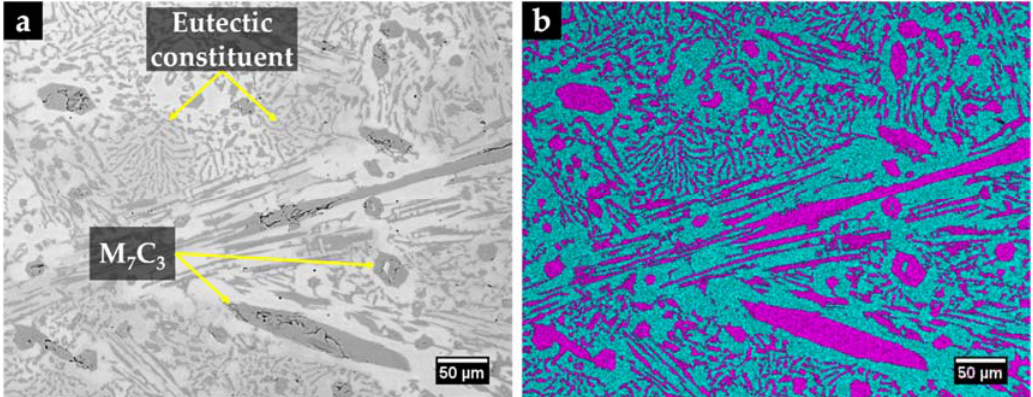
Figure 3. SEM–BSE image of the microstructure of the high-Cr WCI ( a ) and energy-dispersive spectroscopy (EDS) elemental mapping ( b ) with a superposition of Cr (pink) and Fe (blue).